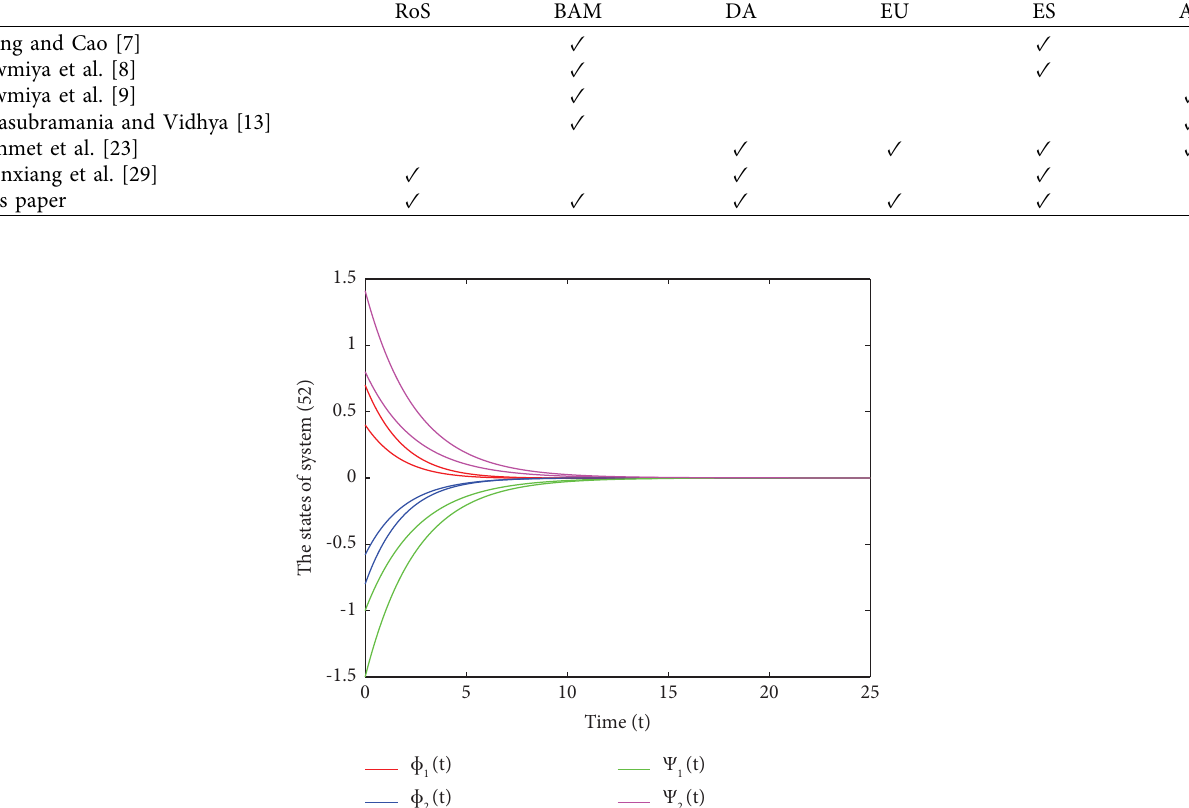
Figure 1: Te states of (77) with Y